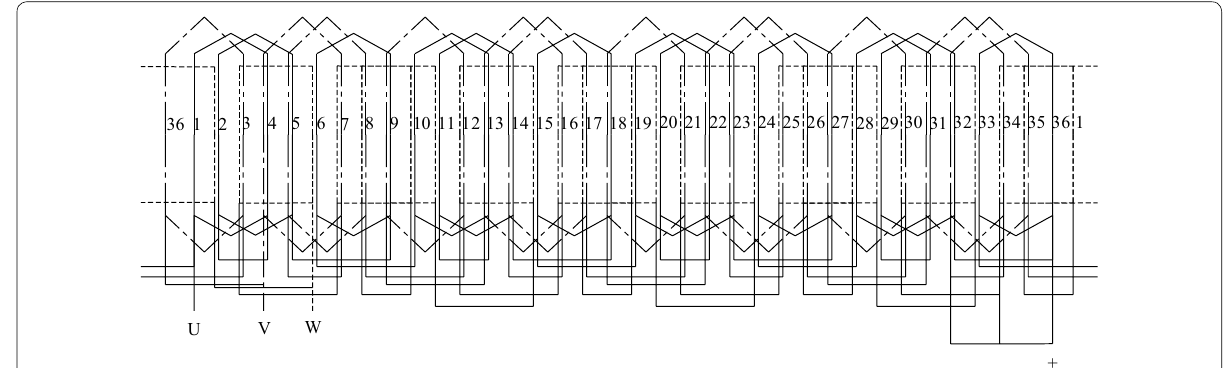
Figure 7 Stator winding embedded line diagram